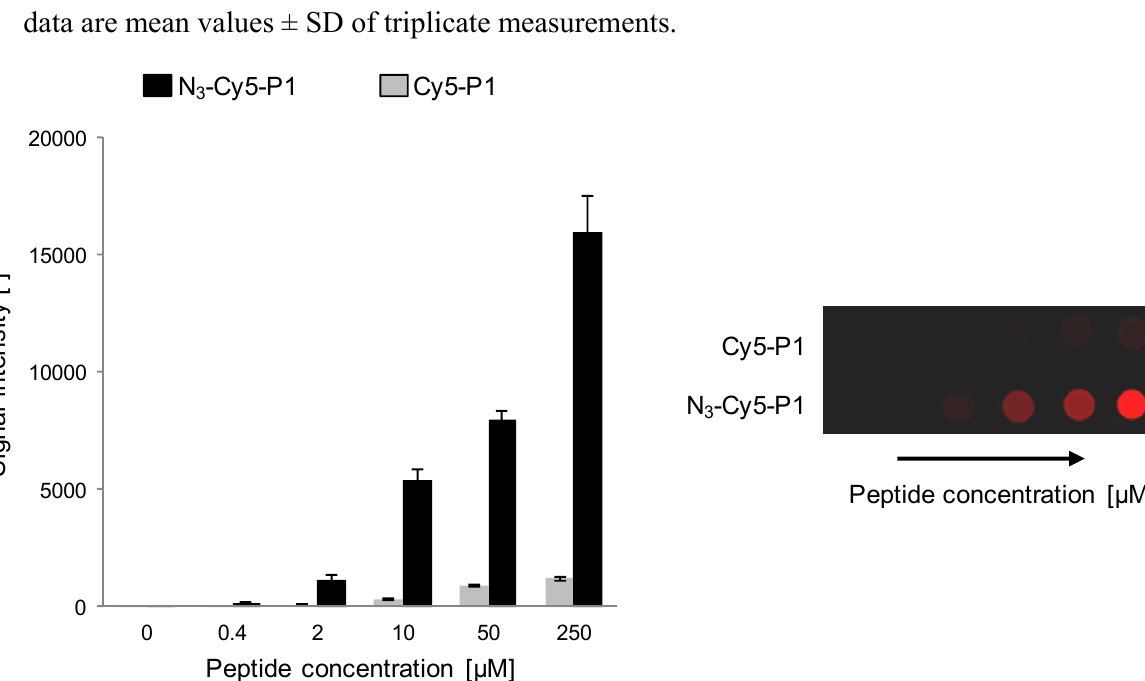
-Cy5-P1 versus non-specific 3